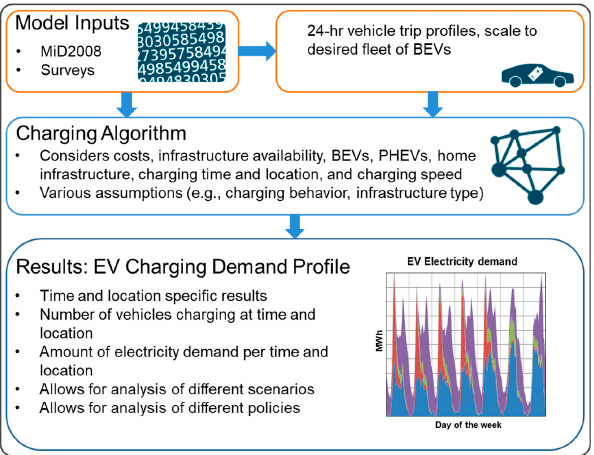
Figure 2. Overview of the transport model CURRENT (charging infrastructure for electric vehicles analysis tool).